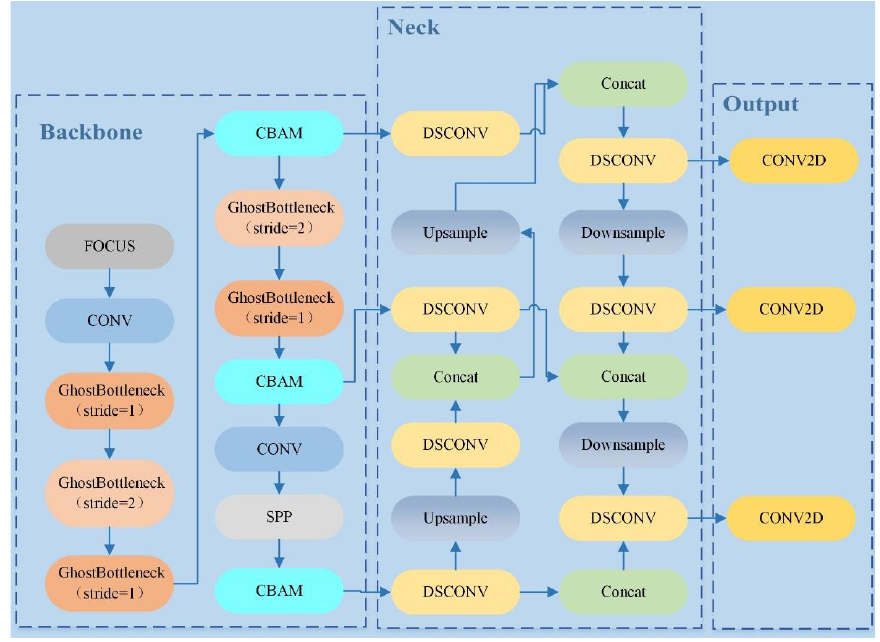
Figure 5. Architecture of the improved YOLOv5.